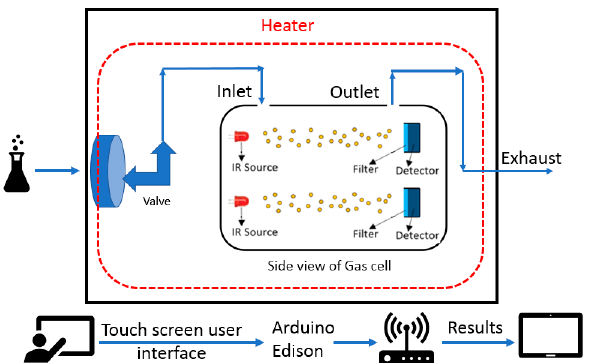
Figure 1. Overview of Optical eNose (the side view of the chamber only shows 2 sensors out of